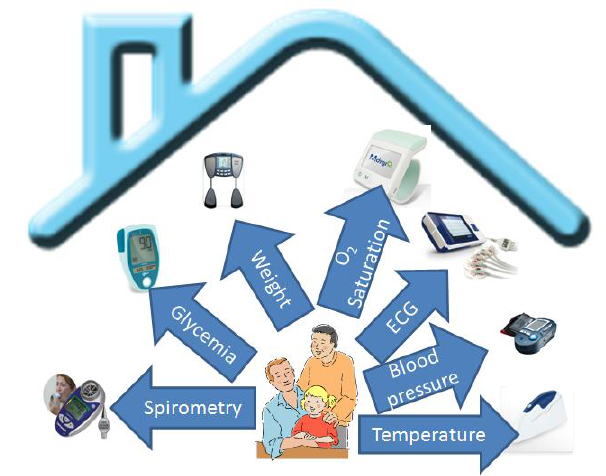
Figure 12. Healthcare sensors used in the AAL environment.